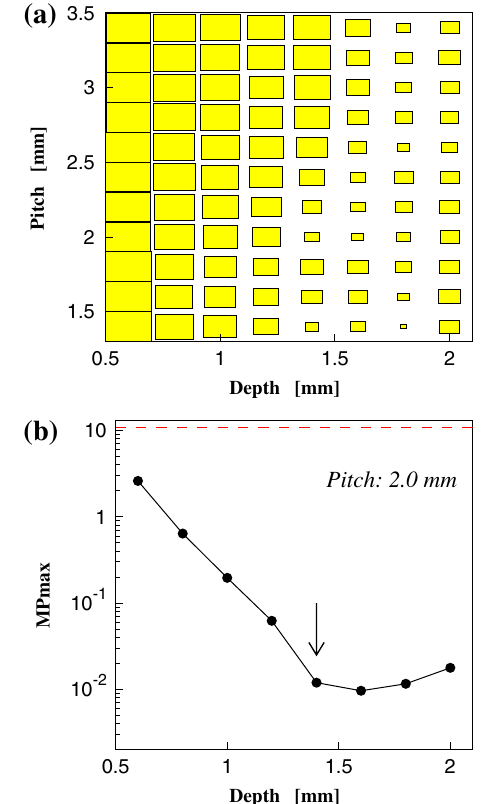
FIG. 5. Maximum values of ~ M in each multipactoring zone map (a) as functions of pitch and depth, shown as areas of boxes in a log-scale plot, and (b) as a function of depth for a pitch of 2.0 mm, where the vertical arrow indicates the selected value of depth, and the horizontal dashed line is for the ungrooved coaxial line.